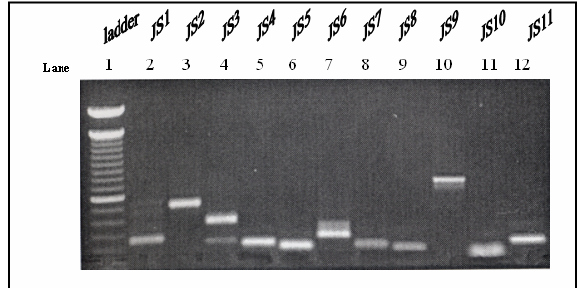
Figure 3: Re-amplification of differentially expressed genes. 1.5% agarose gel of the eleven differentially expressed bands chosen for re-amplification. Lane 1 is 100 bp ladder (Gibco-BRL) and lanes 2-12 are the selected differentially expressed bands (JS1-JS11). The sizes of the differentially expressed bands chosen for reamplification were as follows: JS1, 300 bp; JS2,